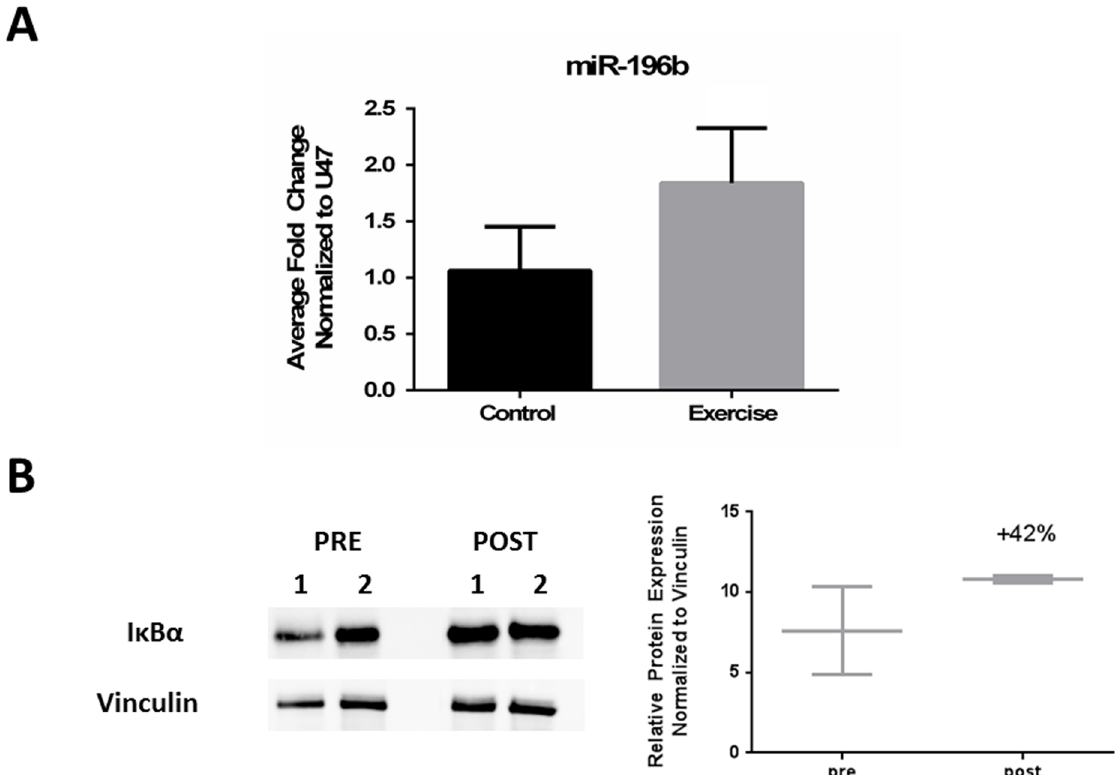
Fig 3. Validation of miR-196b expressionafter exerciseand its associated effect on classical NF- κ Bsignaling. (A) RT- qPCR validatedthat miR-196bwas increasedafter exercise. For normalization, pre Ct values were first subtracted from post Ct values from both miR-196band the housekeeper, U47. Double delta Ct method was then used to calculatethe averagefold change(2^-((Normalized Target-Housekeeper)-(Average(NormalizedControl-Housekeeper)). (B) Western blot in pre-andpost exercisedskeletal muscle shows an averageincrease of 42% in total I κ B α protein after exercise.